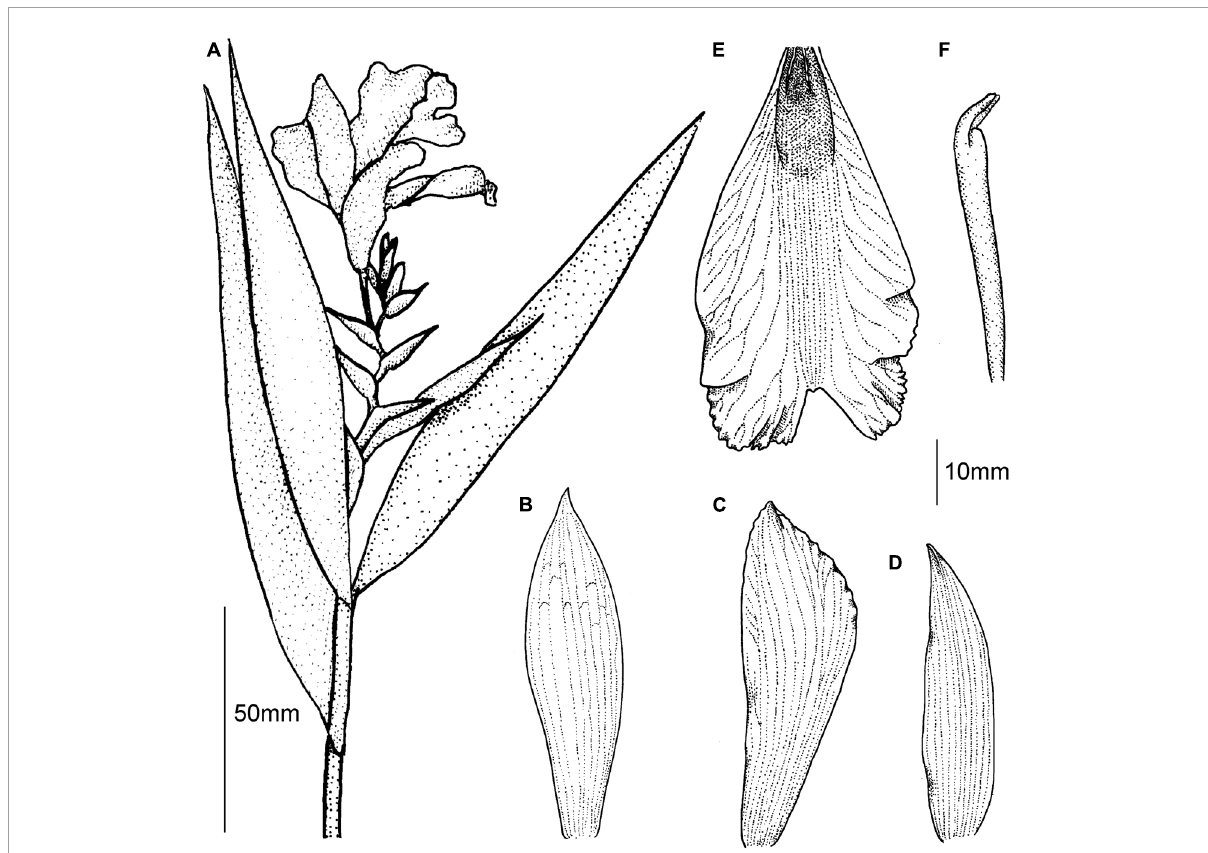
FIGURE4 Sobralia liliastrum Lindl. (A) apical part of stem with inflorescence, (B) dorsal sepal, (C) petal, (D) lateral sepal, (E) lip, and (F) gynostemium, side view (drawn by P. Baranow from the isolectotype kept at MO).